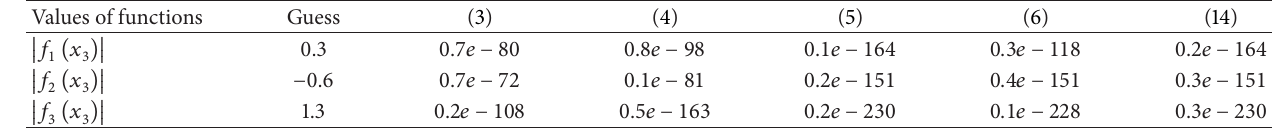
Table 2: Results of comparisons for different methods after three full iterations.